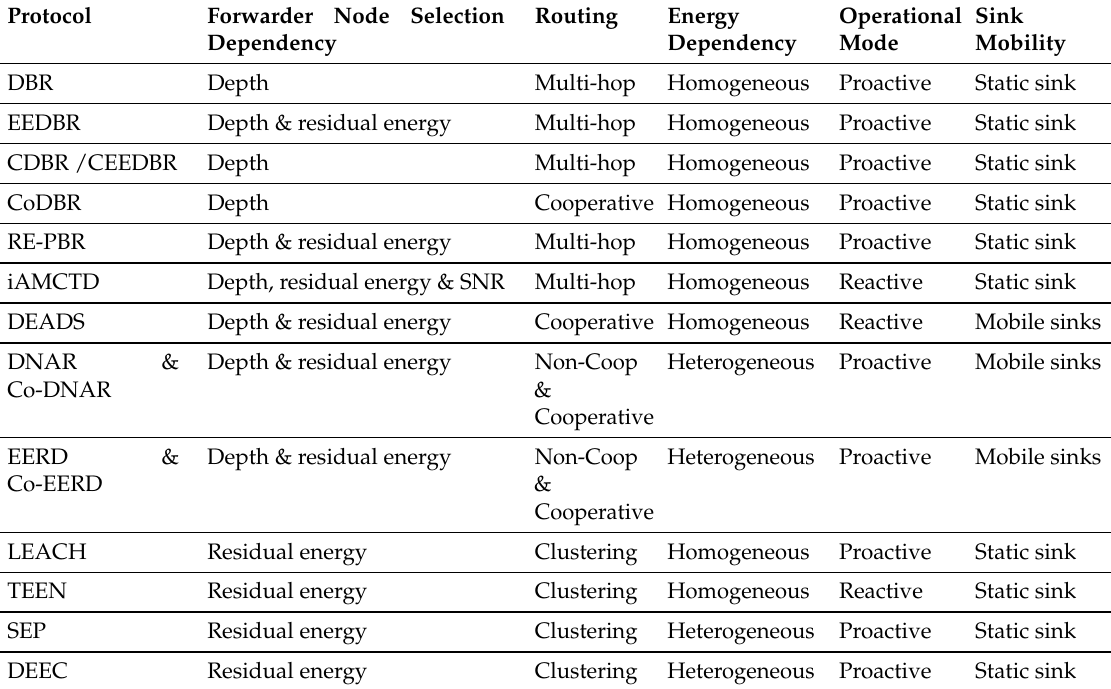
Table 1. Comparison of Existing